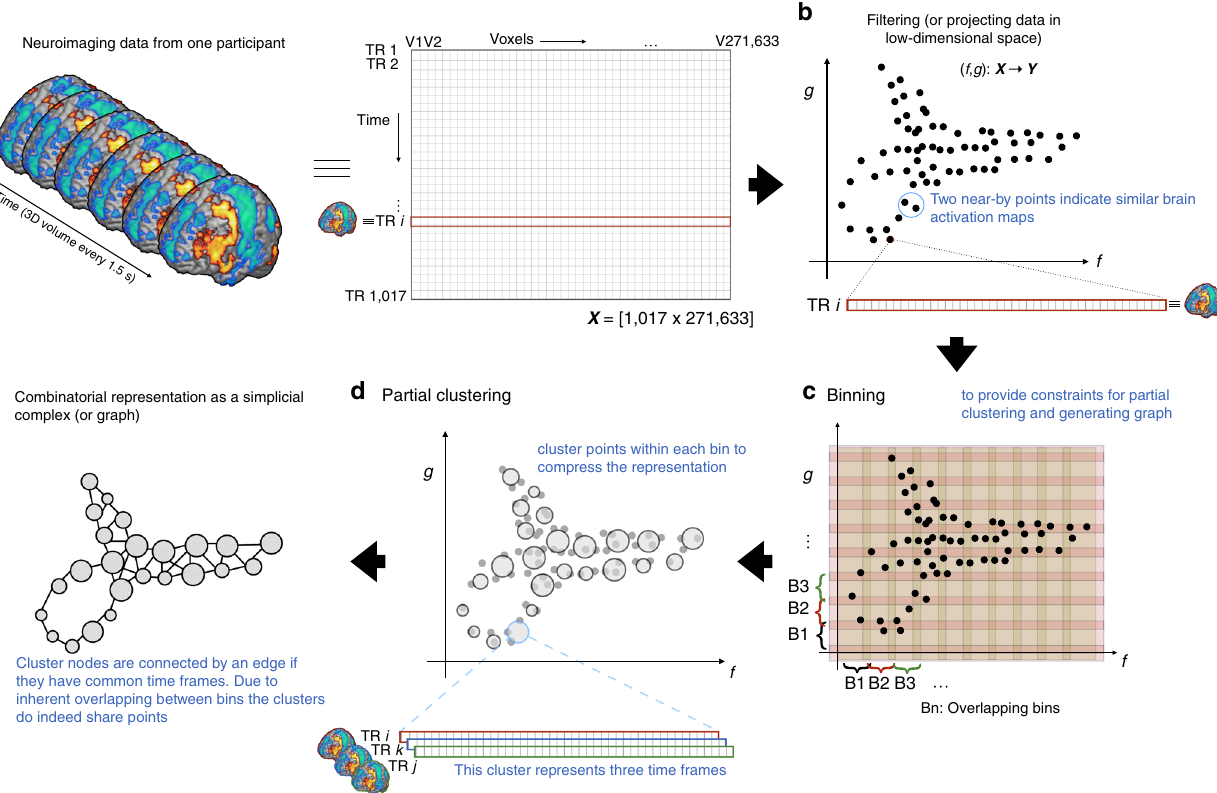
Fig. 1 Application of Mapper to 4D fMRI data. a Pre-processed four-dimensional fMRI data from each participant was fed into the analysis. For each participant, the entire data matrix (i.e., #TRs × #Voxels) was used for analysis. b Non-linear dimensionality reduction was done during the fi ltering step to project fMRI data into a lower two-dimension set (represented by dimensions ( f , g )). c Two-dimensional binning was then performed by dividing the lower- dimension space into smaller bins (determined by the resolution parameter, R ) with certain overlap (determined by the gain parameter, G ). d Partial clustering was then performed to get a compressed representation by collapsing data into fewer nodes, where each node represents a cluster, and the size of each node depicts the number of data points inside each cluster. e After clustering, nodes that share data points (i.e., time frames in this case) are linked together with an edge to create the fi nal compressed combinatorial representation (or